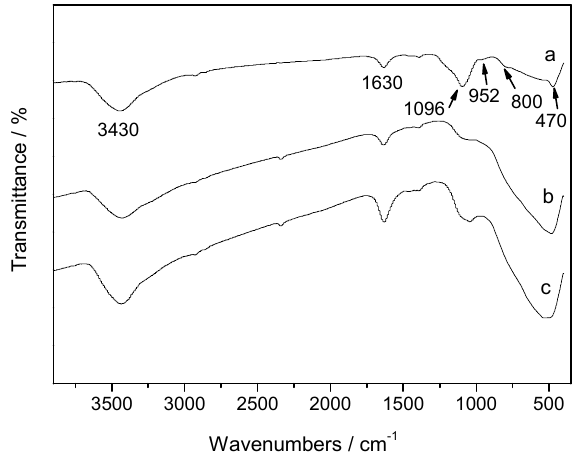
Figure 2. Fourier-transform infrared (FTIR) spectra of (a) R-TiO 2 /SiO 2 ; (b) WH-TiO 2 /SiO 2 ; and (c) D-TiO 2 /SiO 2 .